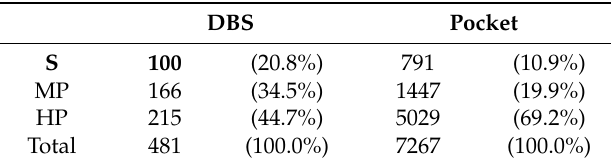
Table 1. The number (and proportion) of DBS in the DBS4 dataset according to their promiscuity level and correspondence with the number (and proportion) of binding pockets: selective (S, in interaction with one Ligand–Cluster), moderately promiscuous (MP, two or three Ligand–Clusters), and highly promiscuous (HP, four or more